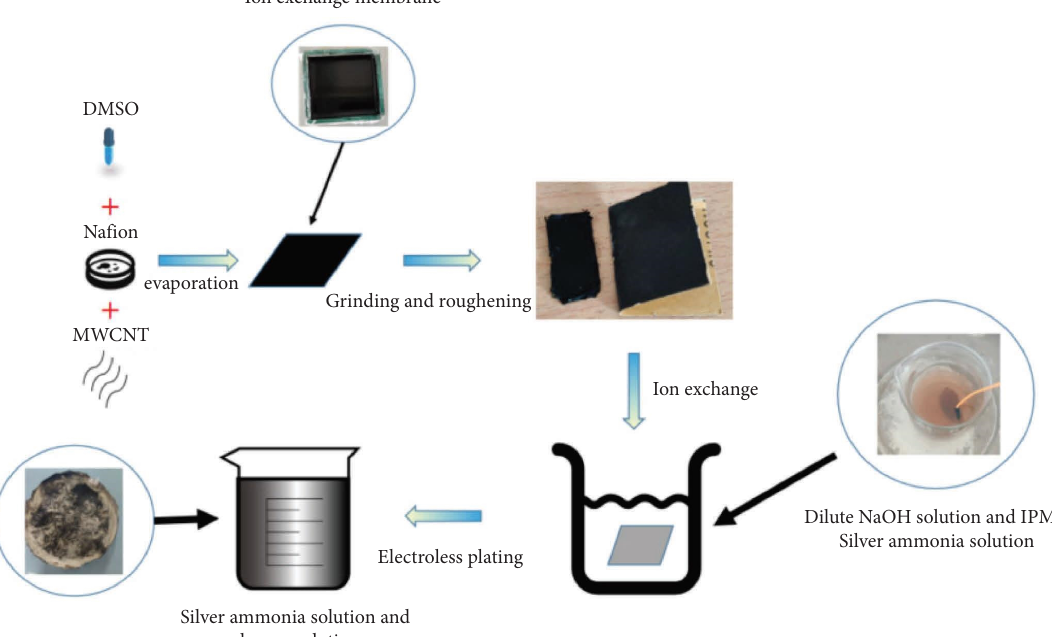
Figure 1: Dry heating preparation process.